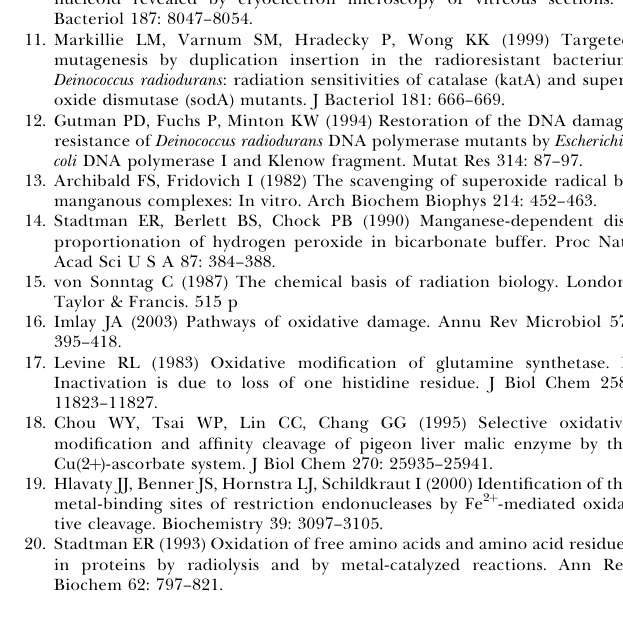
Figure S1. Additional Assays for O 2 /H 2 O 2